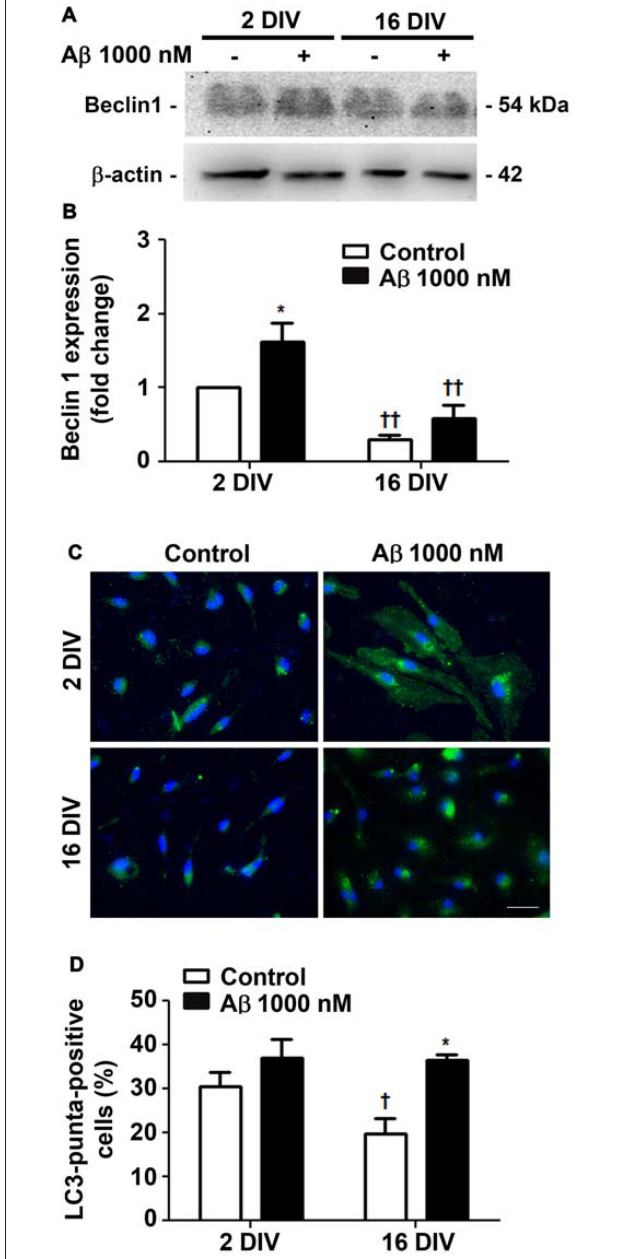
FIGURE 3 | Autophagy is differently promoted by amyloid- β (A β ) peptide in reactive and aged cultured microglia. Microglia that were kept in culture for 2 and 16 days in vitro (DIV) were treated with 1000 nM A β for 24 h. Total cell lysates were analyzed for the presence of Beclin 1. (A) Representative images of Beclin 1 protein expression. (B) Results of densitometric analysis of Beclin 1 blots are expressed in graph bars as mean ± SEM. Microtubule-associated- protein-light-chain-3 (LC3)-positive puncta cells were detected by immunostaining for LC3. (C) Representative images of immunocytochemistry for LC3 (green) and nuclei staining (blue). Scale bar equals 50 µ m. (D) Percentage of cells showing LC3-positive puncta are expressed in graph bars as mean ± SEM. Cultures, n = 4 per group. Two-way ANOVA ( Post hoc Bonferroni test): ∗ p < 0.05 vs. respective non-treated Control; † p < 0.05 and †† p < 0.01 vs. 2